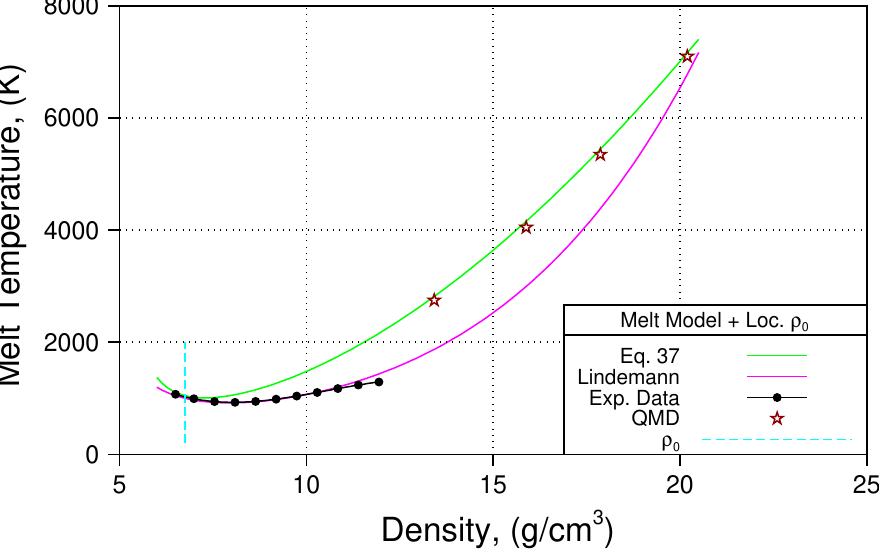
Figure 2. Melt temperature as a function of density (Lindemann parameter set